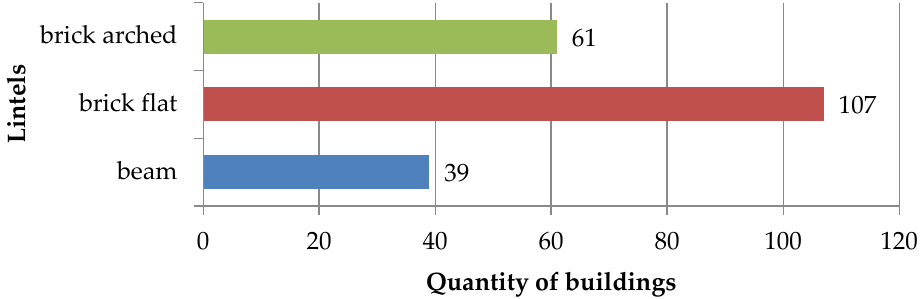
Figure 16. Distribution of data for the variable relating to the ceiling above the basement.